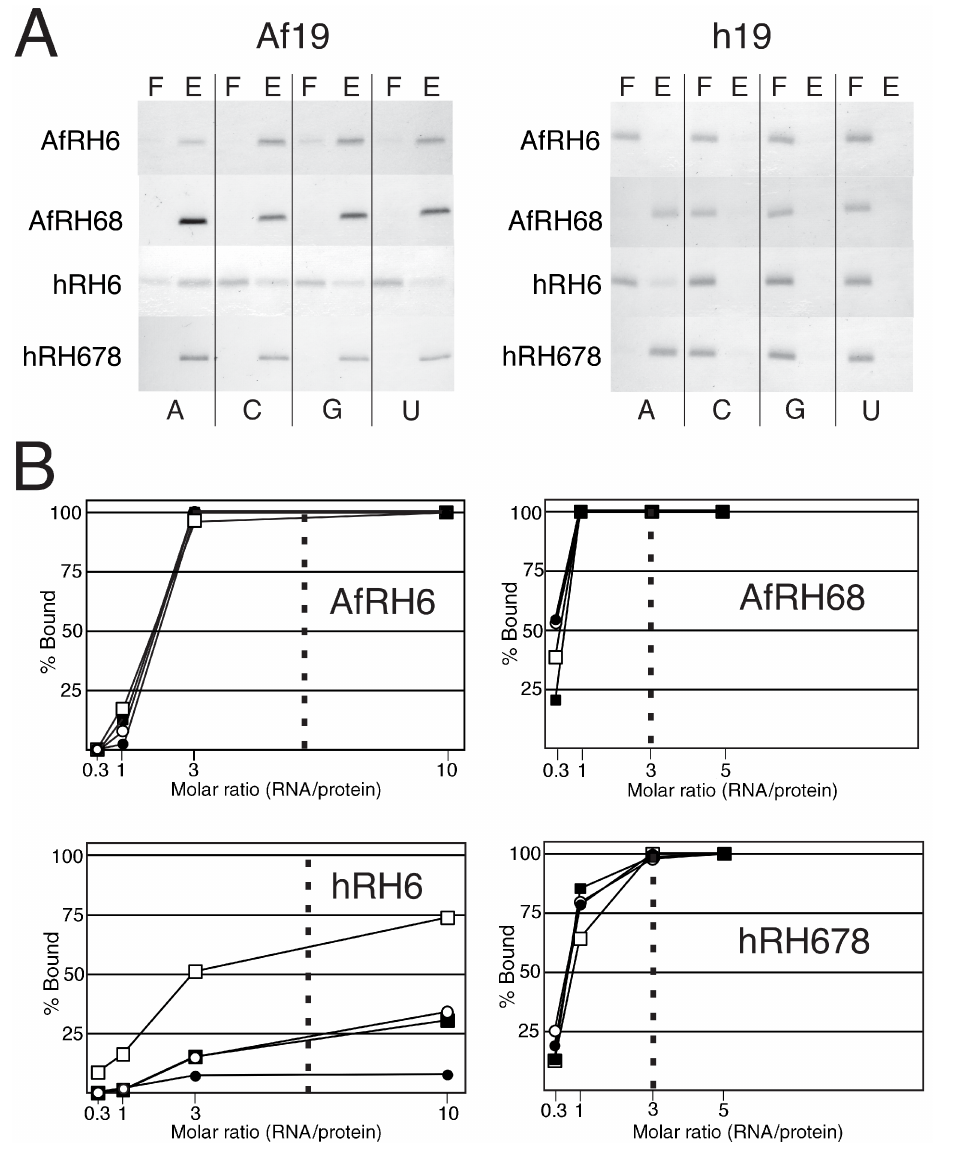
Figure 2. Protein SRP19 binding activities of SRP RNA fragments. (A) SDS- PAGE of A. fulgidus SRP19 (Af19) (left panel) or human SRP19 (h19) (right panel) in the flow- through (F) and high-salt eluate (E) of DEAE-col- umns. The names of the various RNA fragments used in the binding reac- tions are shown on the left of each panel, whereas the identity of the residue at the third position of the helix 6 tetraloop (A, C, G or U) is indicated at the bottom. (B) Quantitative analysis of Af19 binding activities. Binding to wild- type and mutant SRP RNA fragments is indicated by lines connected to sym- bols, where: (cid:2) = wild- type RNA; (cid:3) = A159C mutant; (cid:4) = A159G mu- tant; and (cid:5) = A159U mu- tant. Dashed vertical lines correspond to the condi- tions used for the results shown in the left panel of Figure